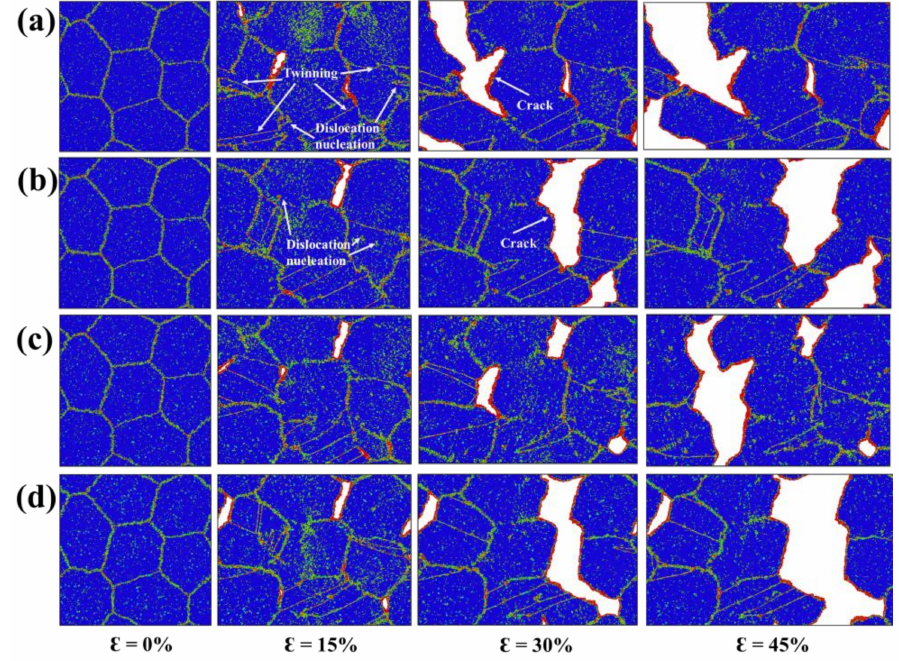
Figure 6. ( a – d ) The atomic snapshots of NG 18 at 0%, 15%, 30% and 45% tensile strains with bulk H concentrations of 0%, 0.25%, 0.5%, 0.75% and 1%, respectively.